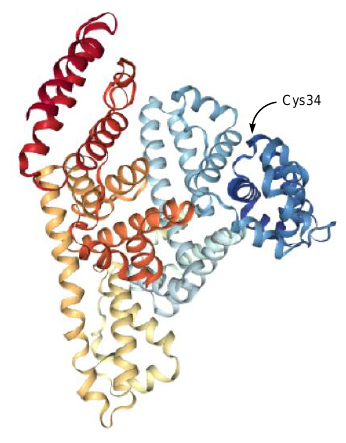
Figure 7. The sequence of human serum albumin 585 amino acids. There are 35 cysteine residues.